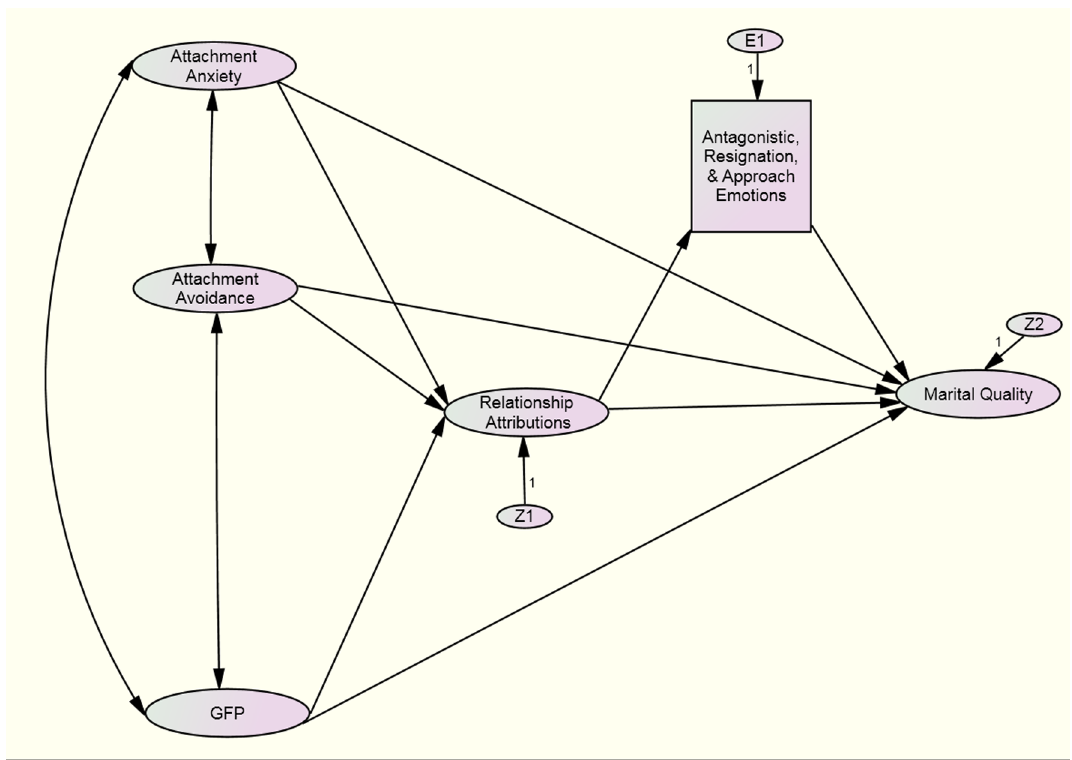
Figure 2. The hypothesized relationships between attachment dimensions, GFP, relationship attributions, emotional reactions, and marital quality.